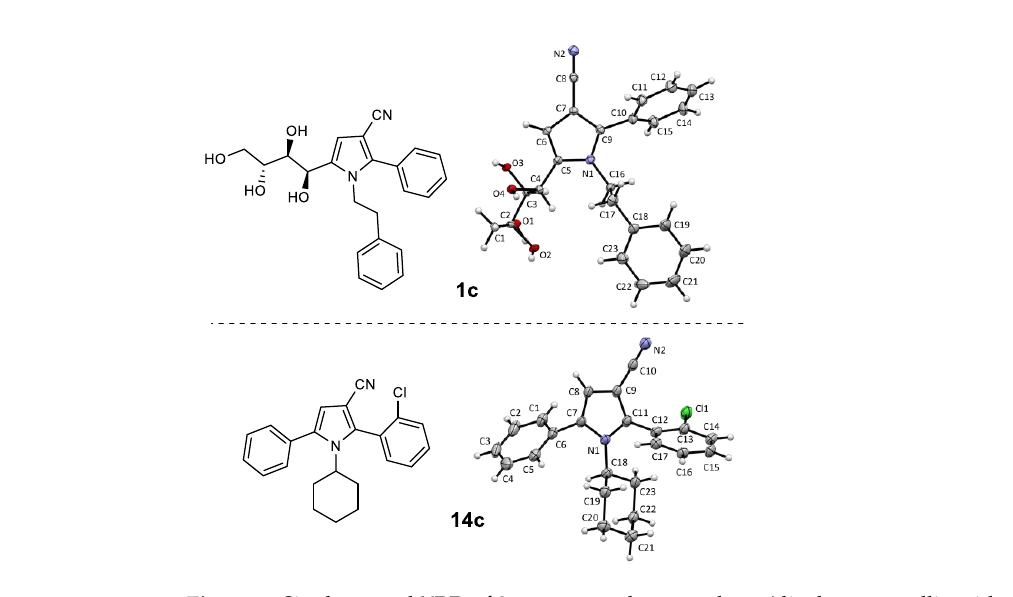
Figure 3. Single-crystal XRD of 3-cyanopyrroles 1c and 14c (displacement ellipsoids are drawn at the 50% probability level).